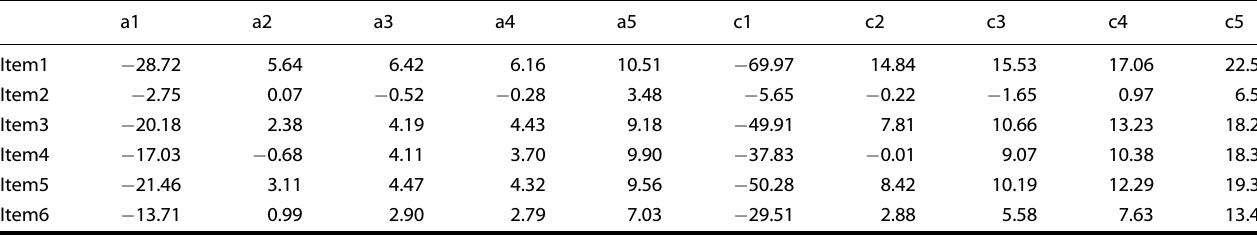
Table 4. Estimated Parameters of